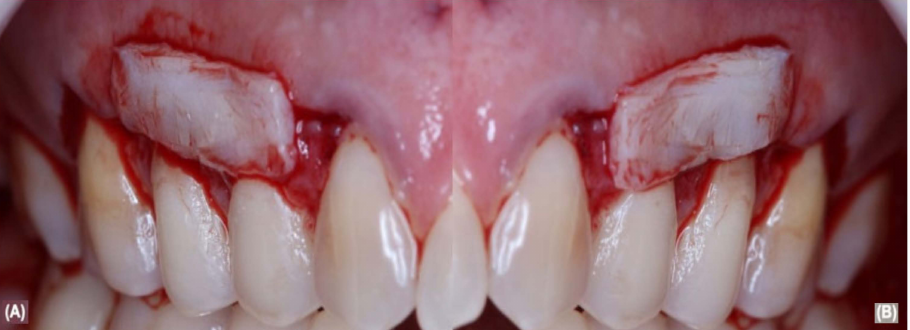
Figure 2. ( A ) shows flap elevated with ACTG on top of right periodontium; ( B ) show flap elevated with ACTG on top of left periodontium.